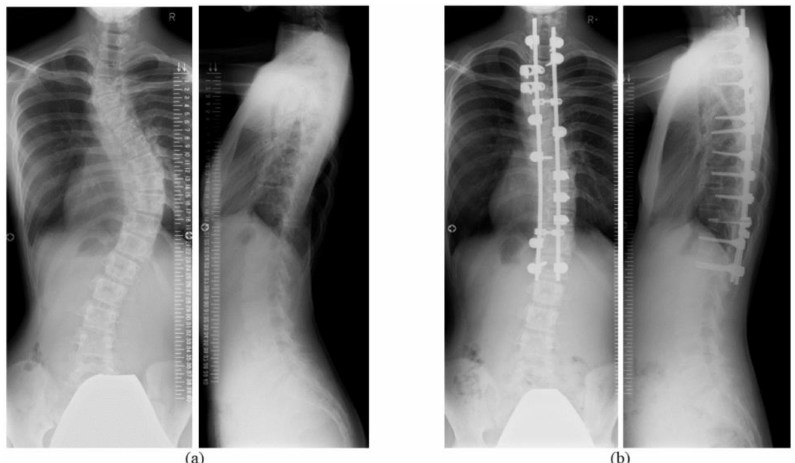
Figure 1. Representative skip pedicle screw fixation for adolescent idiopathic scoliosis. ( a ) Preoperative Cobb angle of the main thoracic curve was 53 ◦ . ( b ) Skip pedicle screw fixation from T1 to L1 improved the scoliotic curve to 17 ◦